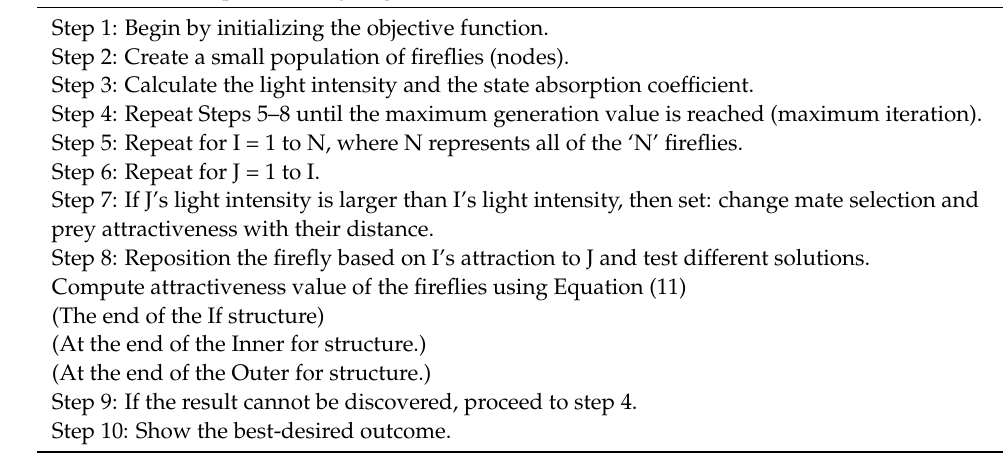
Algorithm 1: (Proposed Firefly Algorithm) With the help of two properties, this approach is used to determine the direct path (shortest) in a network. The first is the firefly’s brightness, which is proportionate to its mate selection and prey attractiveness. The other is that the difference between the couples (two) of fireflies is inversely proportional to the difference between them [20]. Algorithm 1. Proposed Firefly